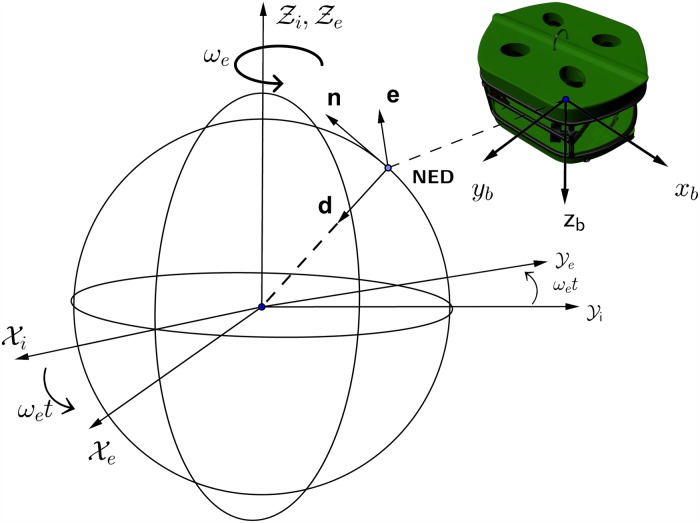
Coordinate systems.